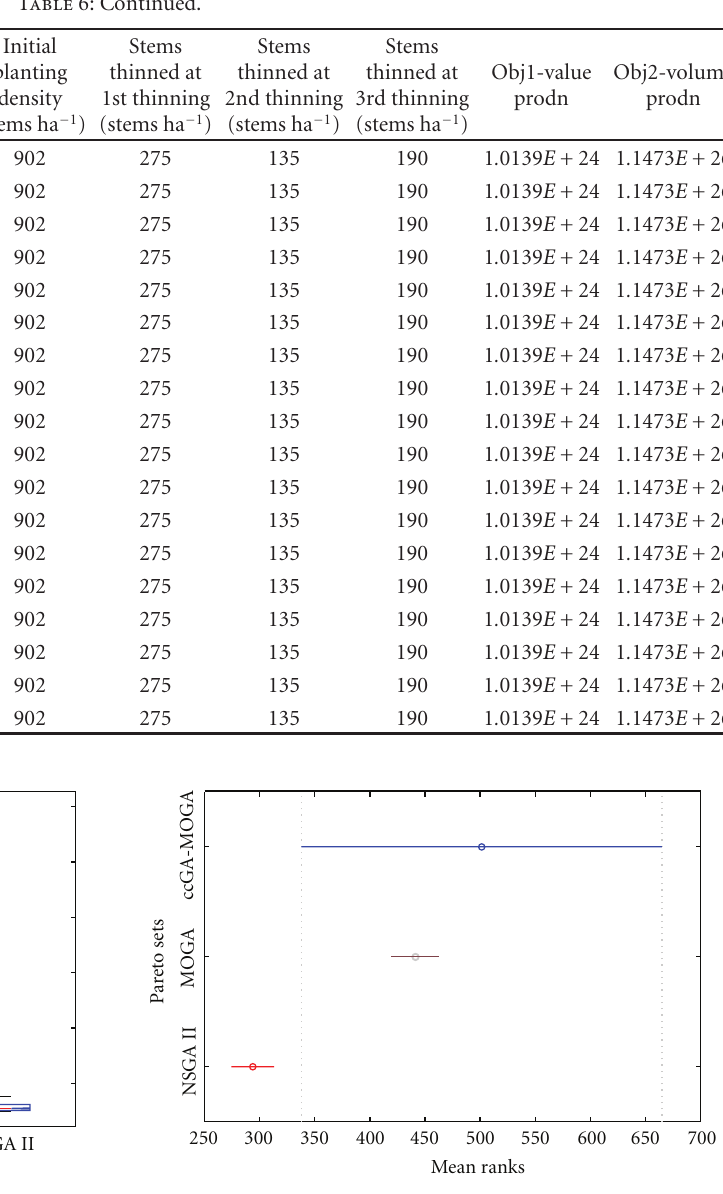
Figure 7: Wilcoxon rank sum test for the initial planting stockings from the ccGA-MOGA, MOGA, and NSGA II Pareto